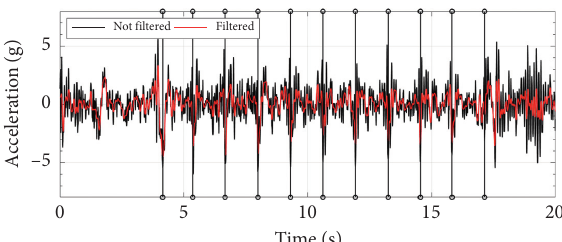
Figure 7: Acceleration time series acquired by a moving force-balance accelerometer while crossing the Le Grotte viaduct.